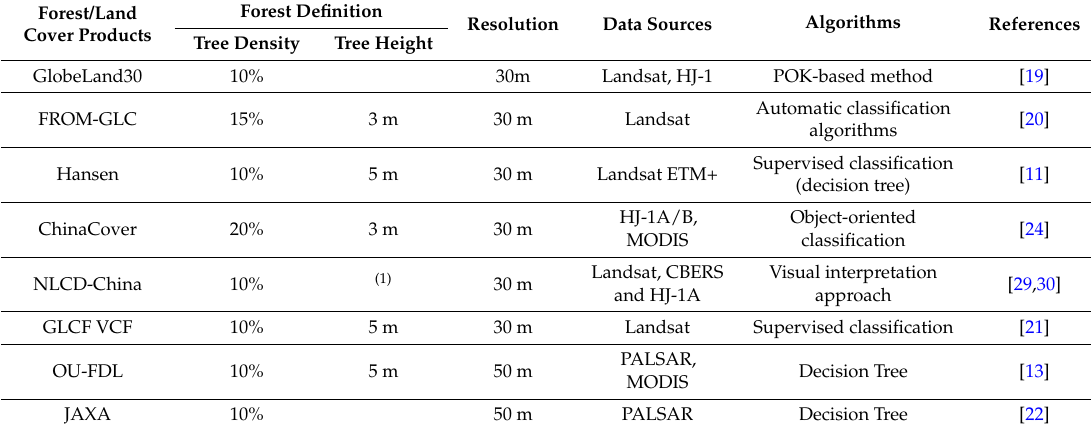
Table 1. A brief summary of the basic characteristics of the eight remote sensing forest products used in this